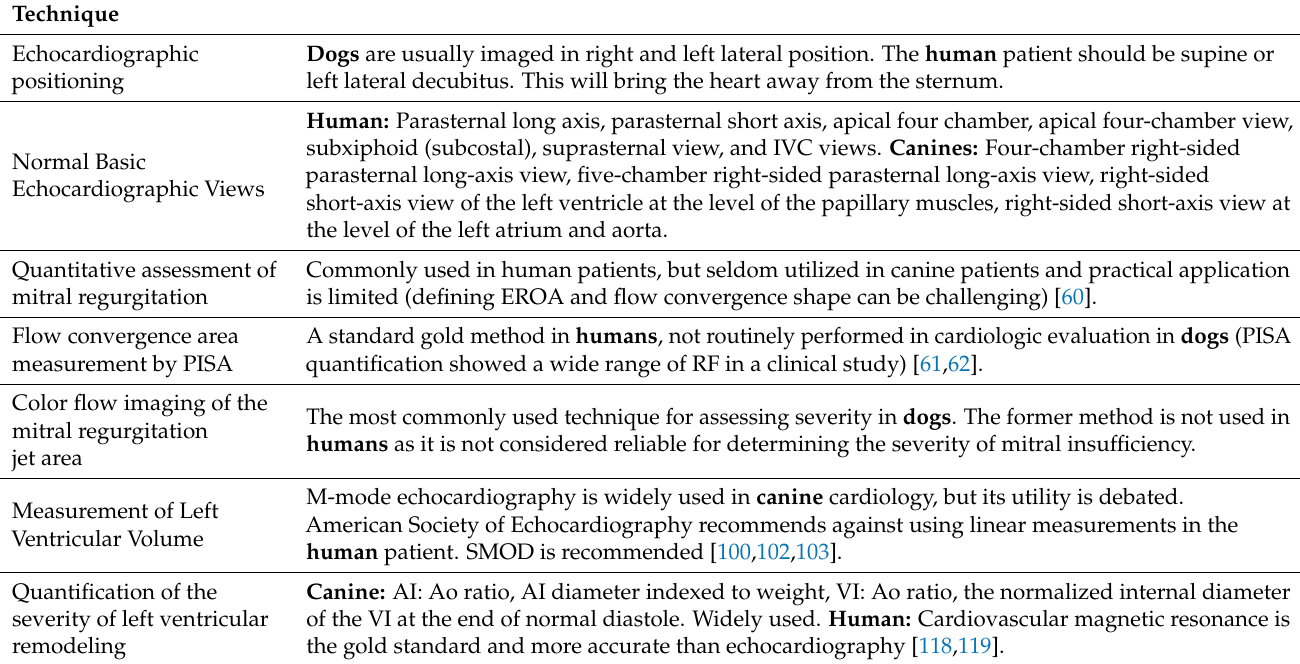
Table 1. Comparison of Transthoracic Echocardiographic Techniques in Humans and